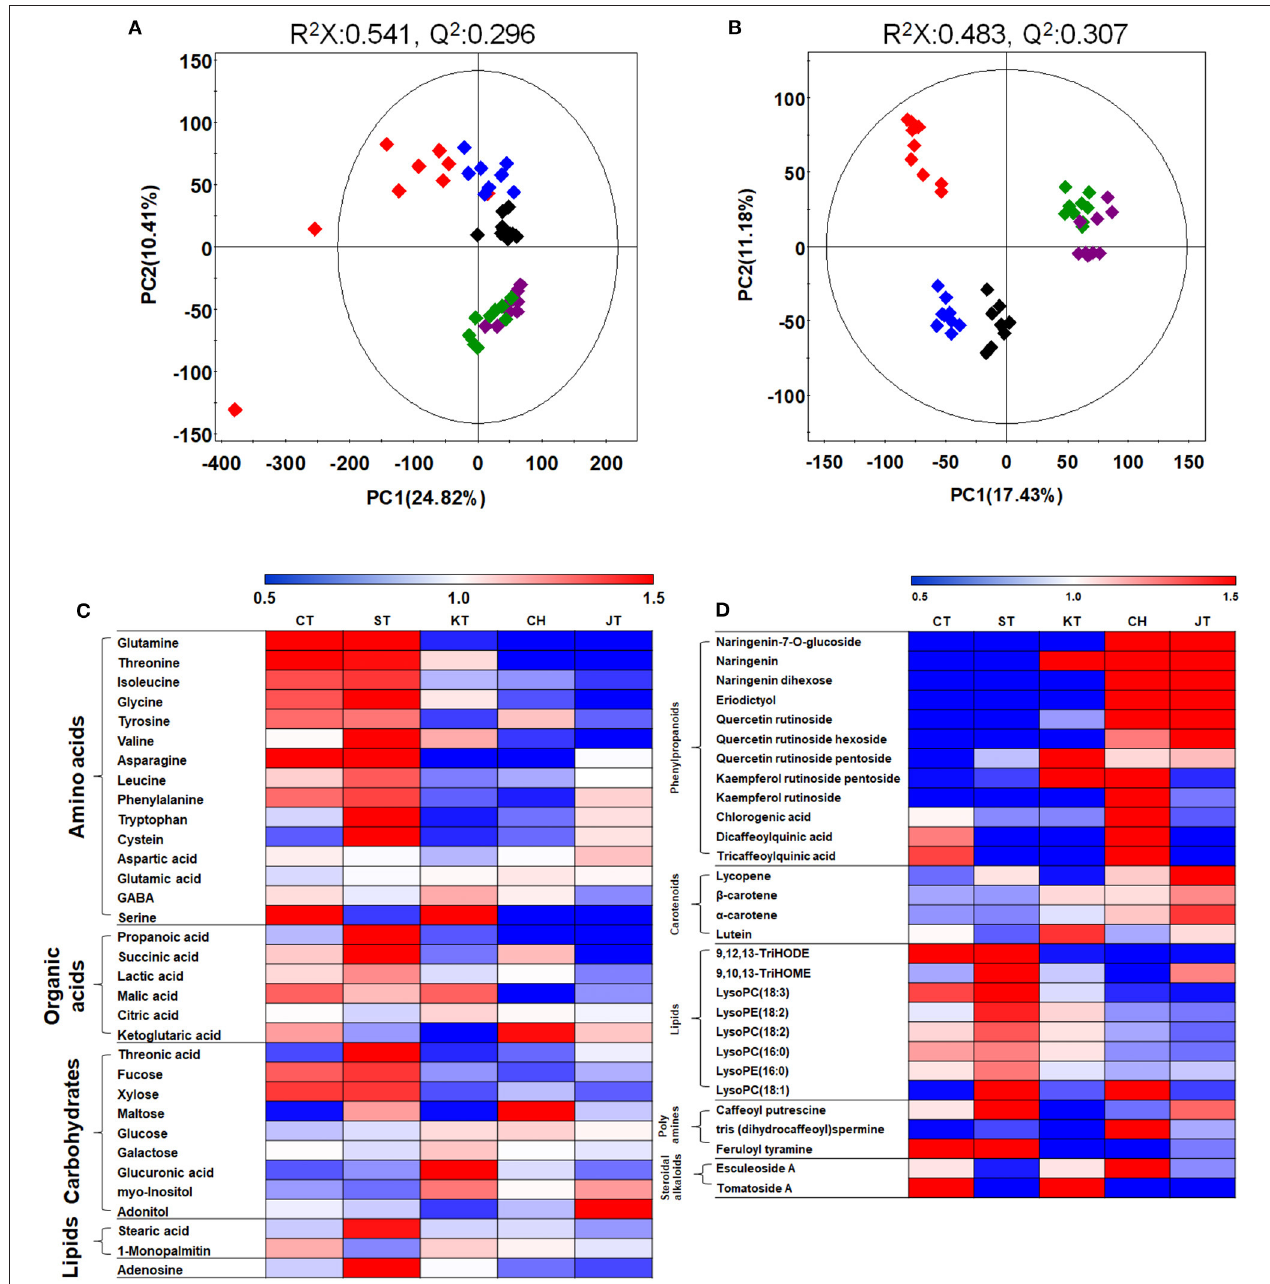
FIGURE 3 | Principal component analysis (PCA) (A,B) score plots for metabolites in five types of tomato based on GC-TOF-MS (A) and UHPLC-LTQ-Orbitrap-MS/MS (B) data set. Heat map analysis of five tomato types based on GC-TOF-MS (C) and UHPLC-LTQ-Orbitrap-ESI-MS/MS (D) data. Heat map representation of the relative abundance of significantly discriminant metabolites (VIP > 0.7, p -value < 0.05) based on PLS-DA model ( Supplementary Figure 1 ). Chal tomato ( ), tomato ( ), kumato ( ), cherry tomato ( ), and jujube-shaped cherry tomato ( ) samples. GC-TOF-MS, gas chromatography time-of-flight mass spectrometry; UHPLC-LTQ-Orbitrap-MS/MS, ultrahigh-performance liquid chromatography–linear trap quadrupole-orbitrap–tandem mass spectrometry; VIP, variable importance projection; PLS-DA, partial least squares-discriminant